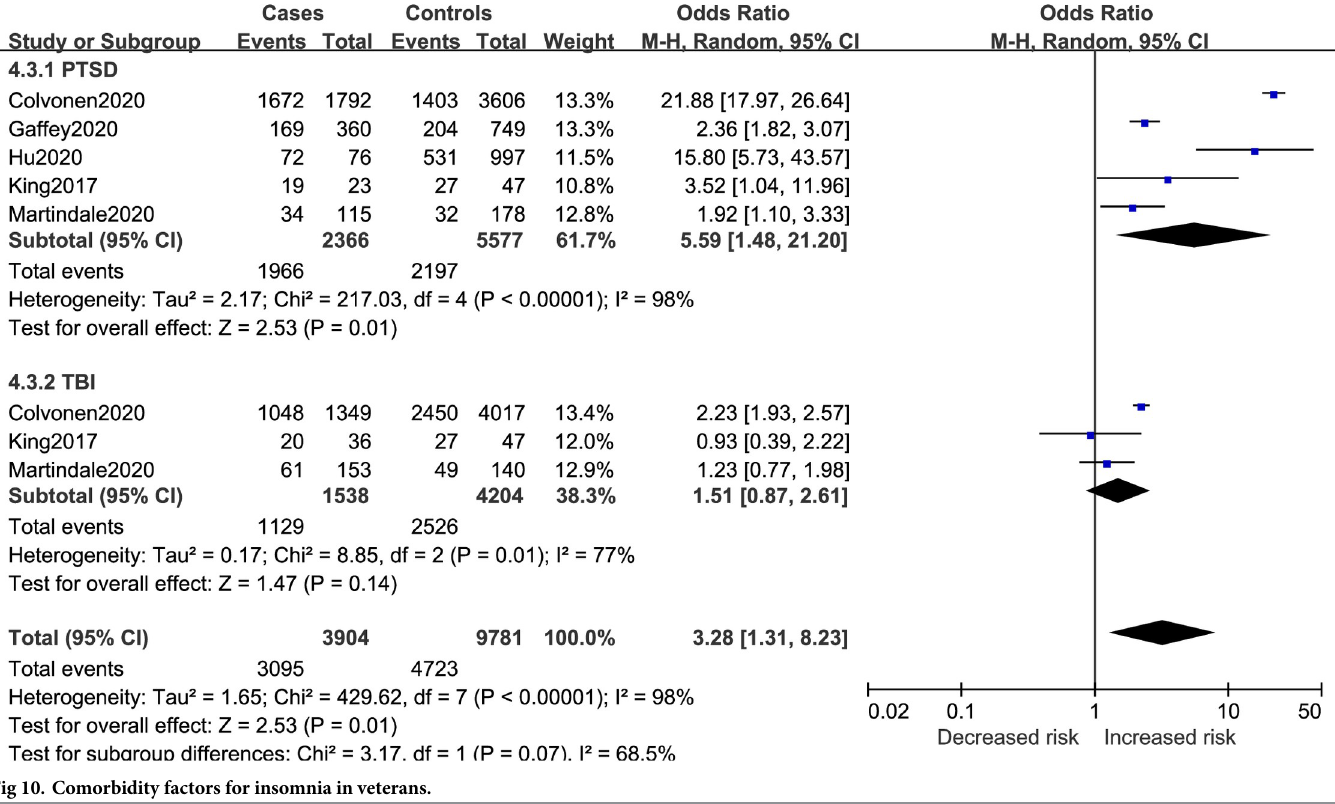
PLOS ONE | https://doi.org/10.1371/journal.pone.0250779 May 6,